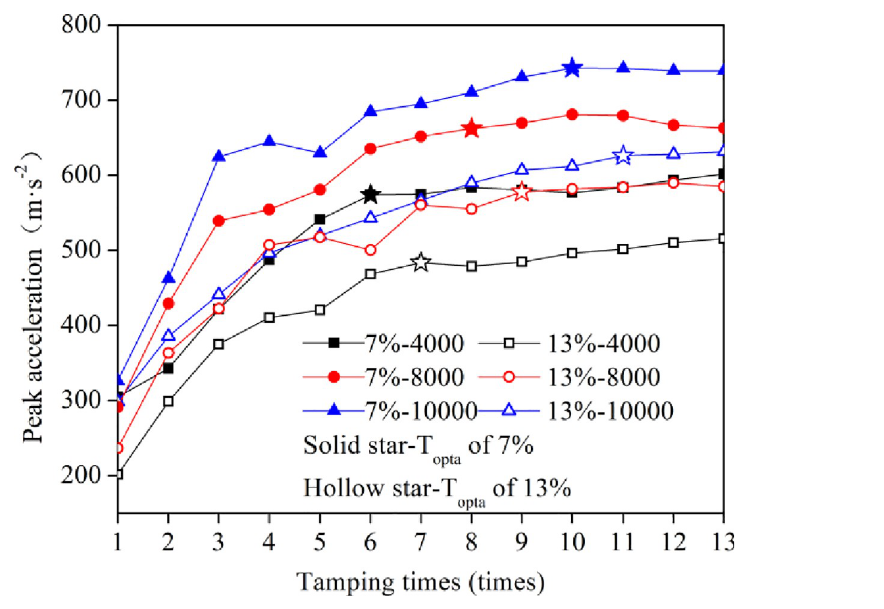
Fig 7. Curves of the peak acceleration verses tamping